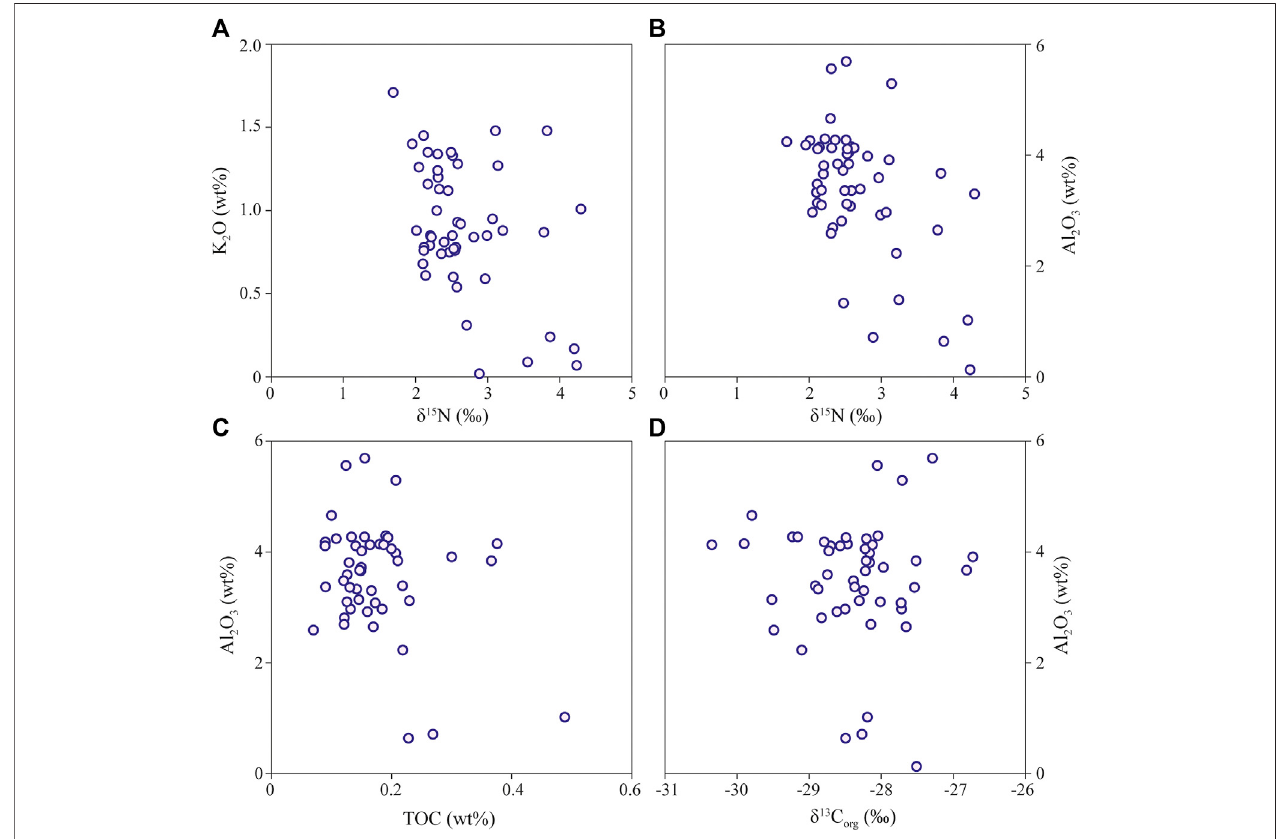
FIGURE5| CrossplotsofK 2 Ovs. δ 15 N (A) ,Al 2 O 3 vs. δ 15 N (B) ,Al 2 O 3 vs.TOC (C) ,andAl 2 O 3 vs. δ 13 C org (D) intheXiangerwansection.TheAl 2 O 3 andK 2 Odataare from Wang (2019).